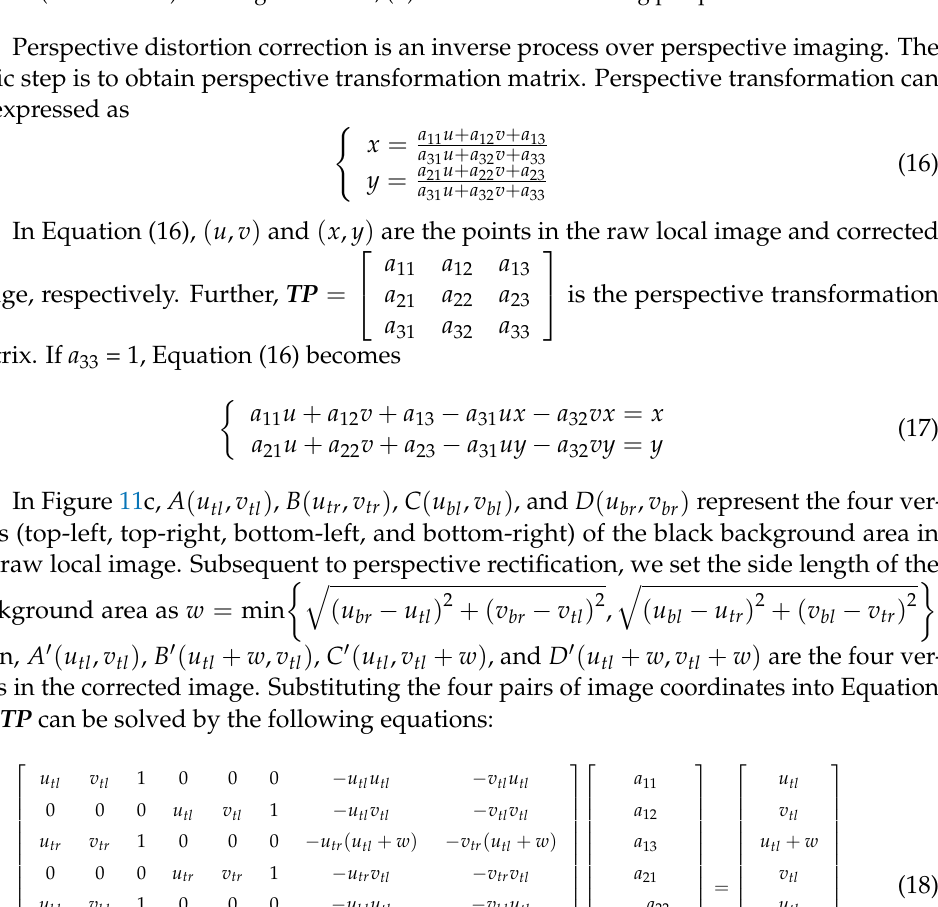
Figure 11. ( a ) The raw local image (ROI); ( b ) The result of Canny edge detection with adaptive double thresholds; ( c ) The result of determining the truth projected center (the green ‘*’) and the four vertices (the color ‘O’) of background area; ( d ) The result of correcting perspective